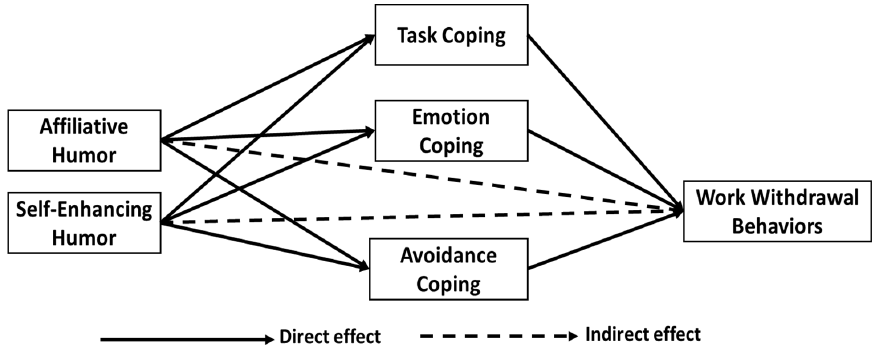
Figure 1. The proposed conceptual framework and hypotheses.